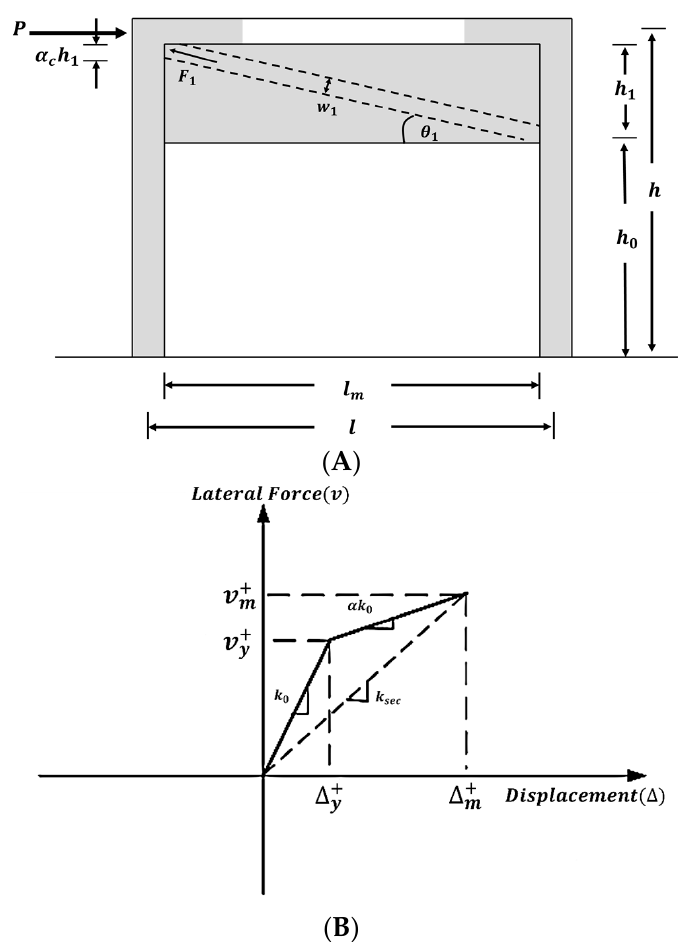
Figure 2. Part of the wall frame model. ( A ) An analytical model of the brick wall according to the equivalent compressive brace frame method. ( B ) Relation of the lateral force to the displacement value.